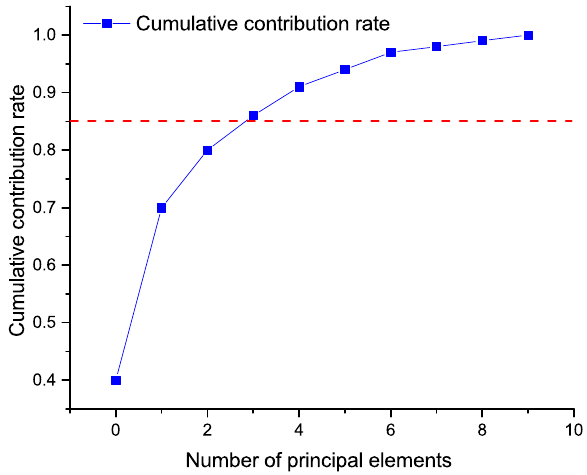
Figure 1. Cumulative contribution rate method to determine the number of principal